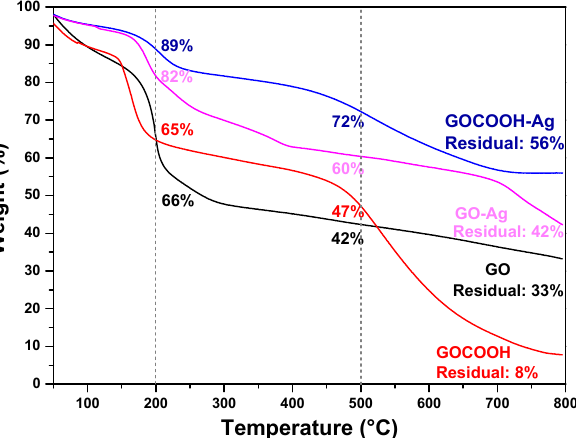
Figure 3. Thermogravimetric curves for GO, GOCOOH, GO-Ag, and GOCOOH-Ag.